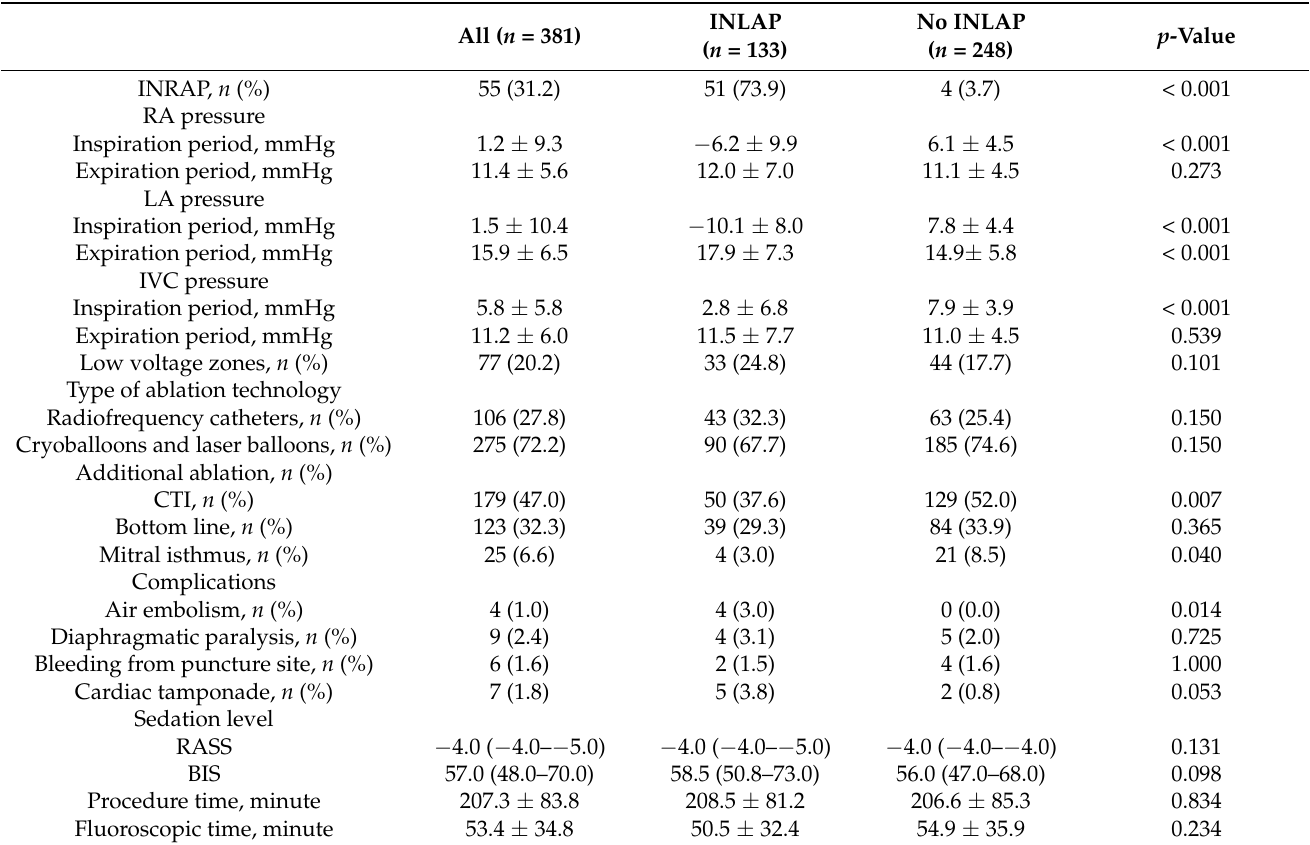
Table 2. Procedural characteristics in patients with and without INLAP. All ( n = 381)